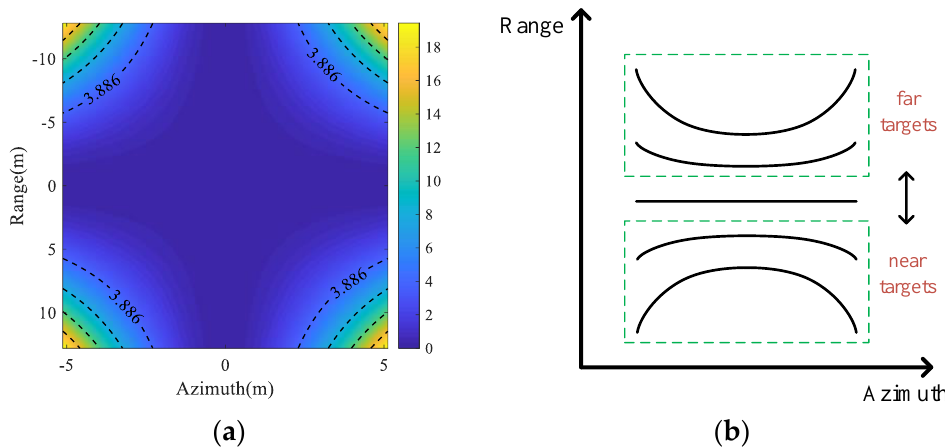
Figure 4. Schematic diagram of space-variant range curvature. ( a ) The phase error of space-variant curvature term; ( b ) Correction range curvature by an approximate method.